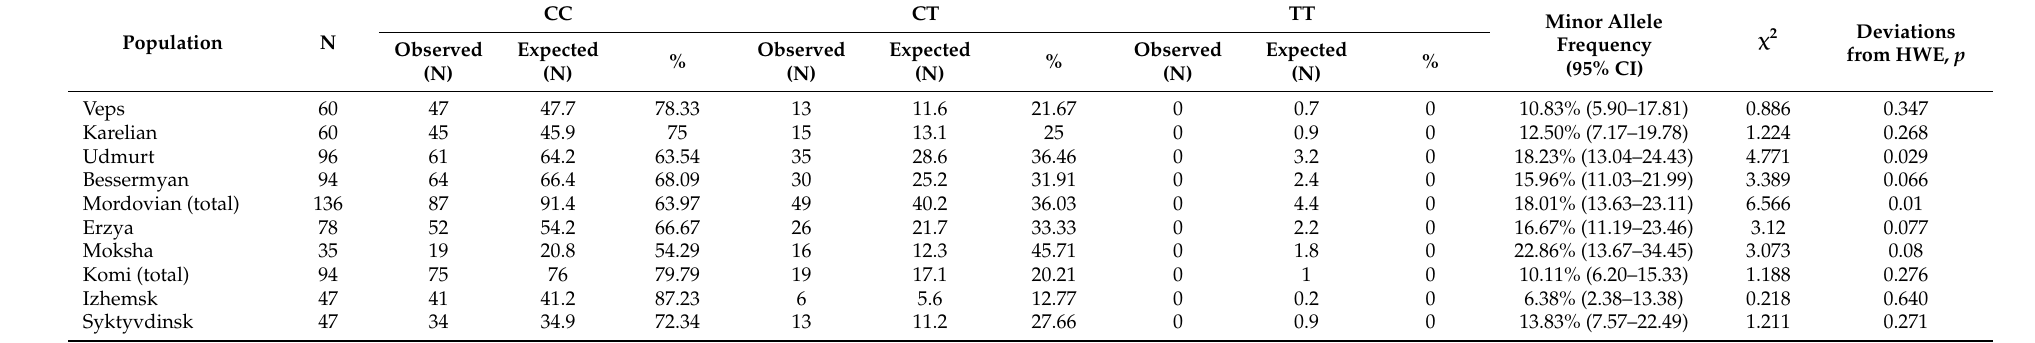
Table 4. Distribution of the rs1065852 genotypes of the CYP2D6 gene in the Finno-Permic populations of the Russian Federation.